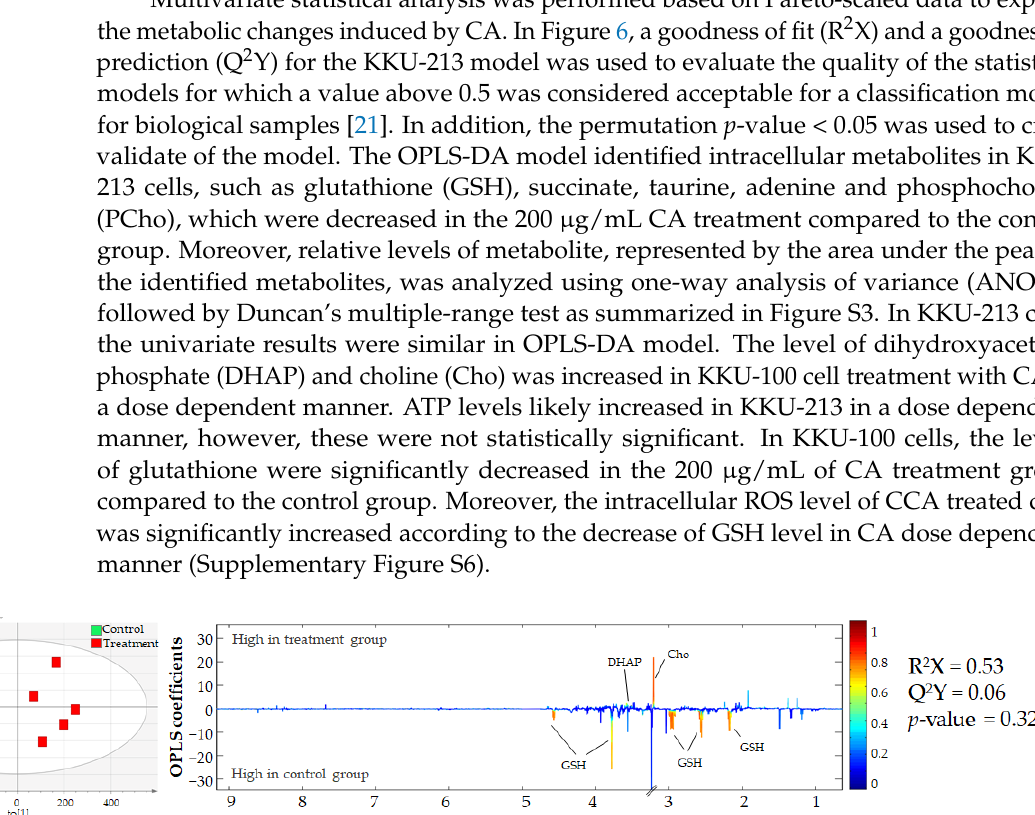
Figure 7. OPLS-DA scores and loading plots displaying significant extracellular metabolites after treatment with or with- out 200 μ g/mL CA on ( a ) KKU-100 and ( b ) KKU-213 cell lines. The positive peaks of the OPLS-DA loading plot indicate metabolites higher in the treatment group, whereas the negative peaks represent metabolites higher in the control group. The color of the peaks corresponds to the correlation coefficients in the discrimination model. 4. Discussion